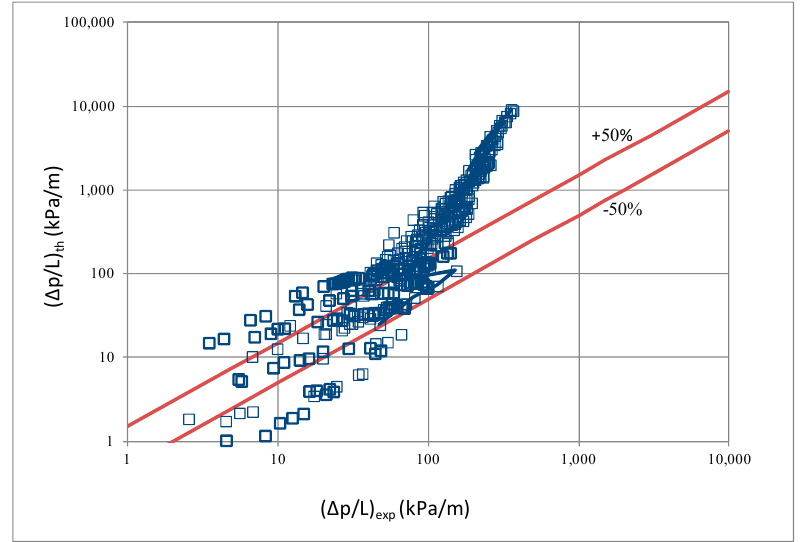
Figure 15. Comparison of the experimental research results on the pressure drops ( Δ p/L) with the results of the calculations according to correlation of Mikielewicz et al. [9] for HFE 7000 refrigerant. Table 2. Comparison of heat transfer investigation results with the results of calculations according to the correlations of various authors [10,21–25]. Corelation Thome